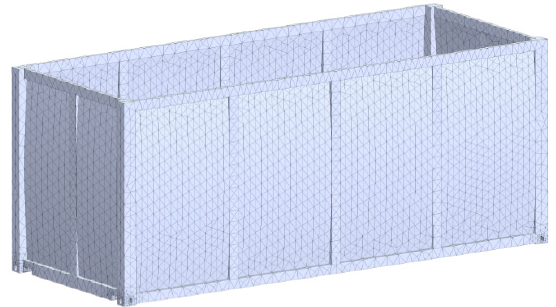
Figure 8. FEM of a container.